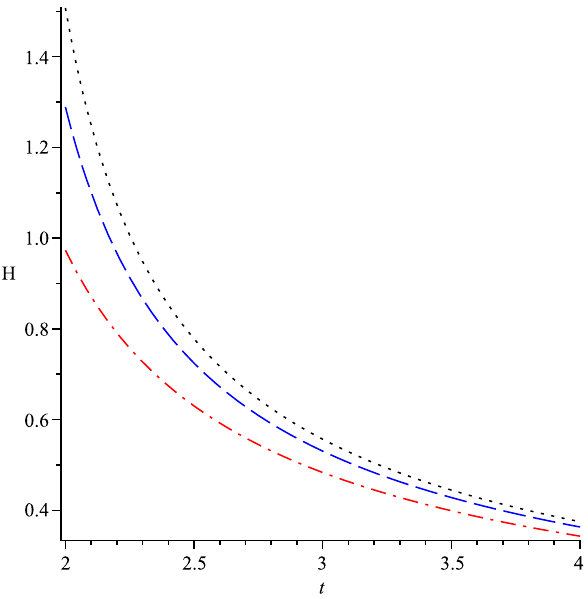
Fig. 6 Represents the variation of acceleration parameter vs t for γ =